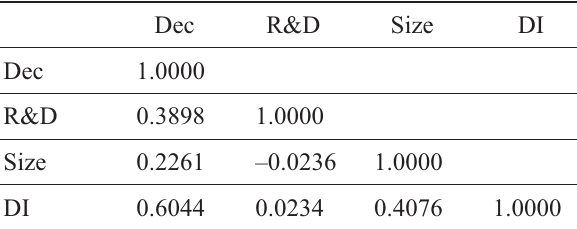
Table 1. Correlation coeffi cient